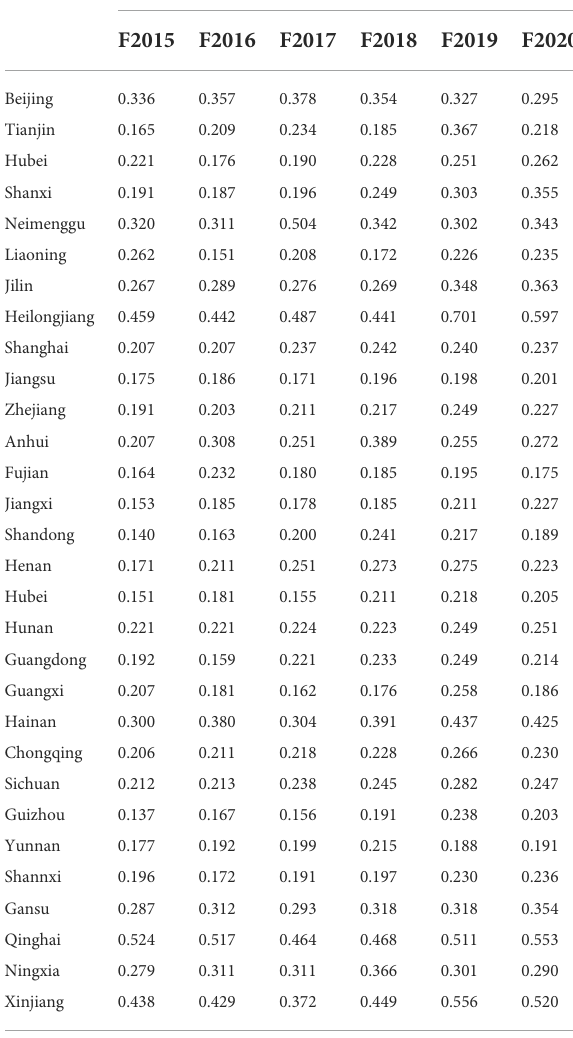
TABLE 3 2015 – 2020 green fi nance comprehensive scores of provinces and